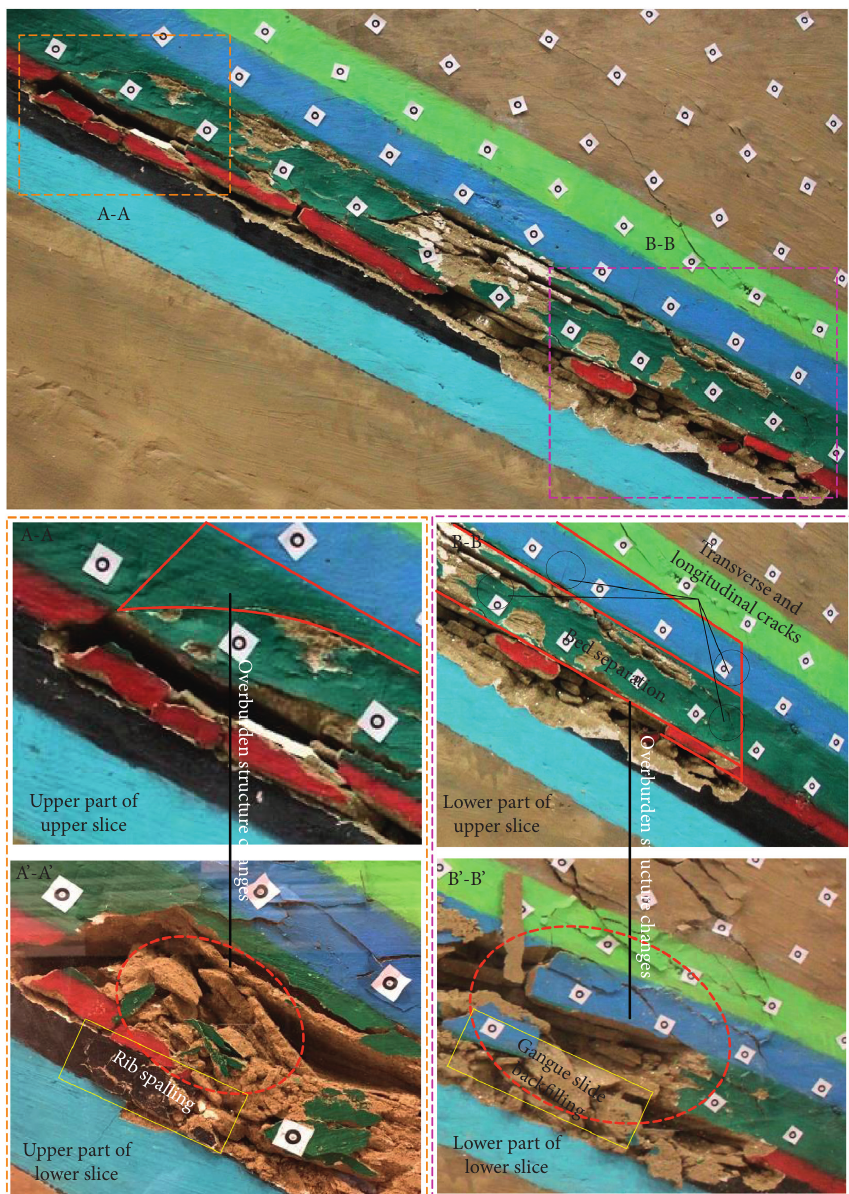
Figure 5: Workface overburden structure variation